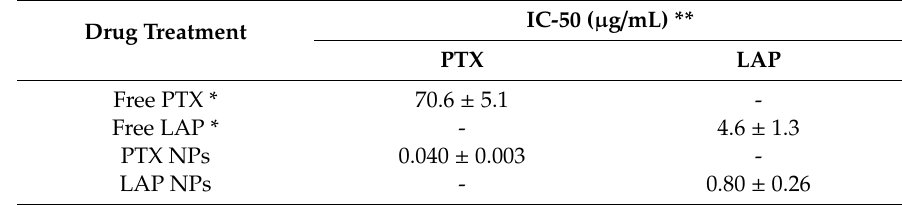
IC-50 of paclitaxel, paclitaxel nanoparticles, lapatinib, and lapatinib nanoparticles in OVCA-432 cells. Drug